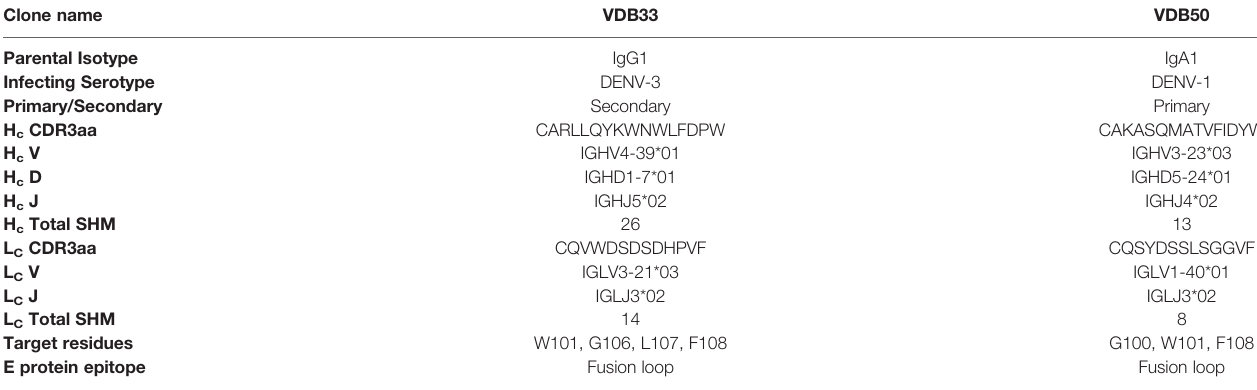
TABLE 1 | Sequence information of DENV-reactive monoclonal